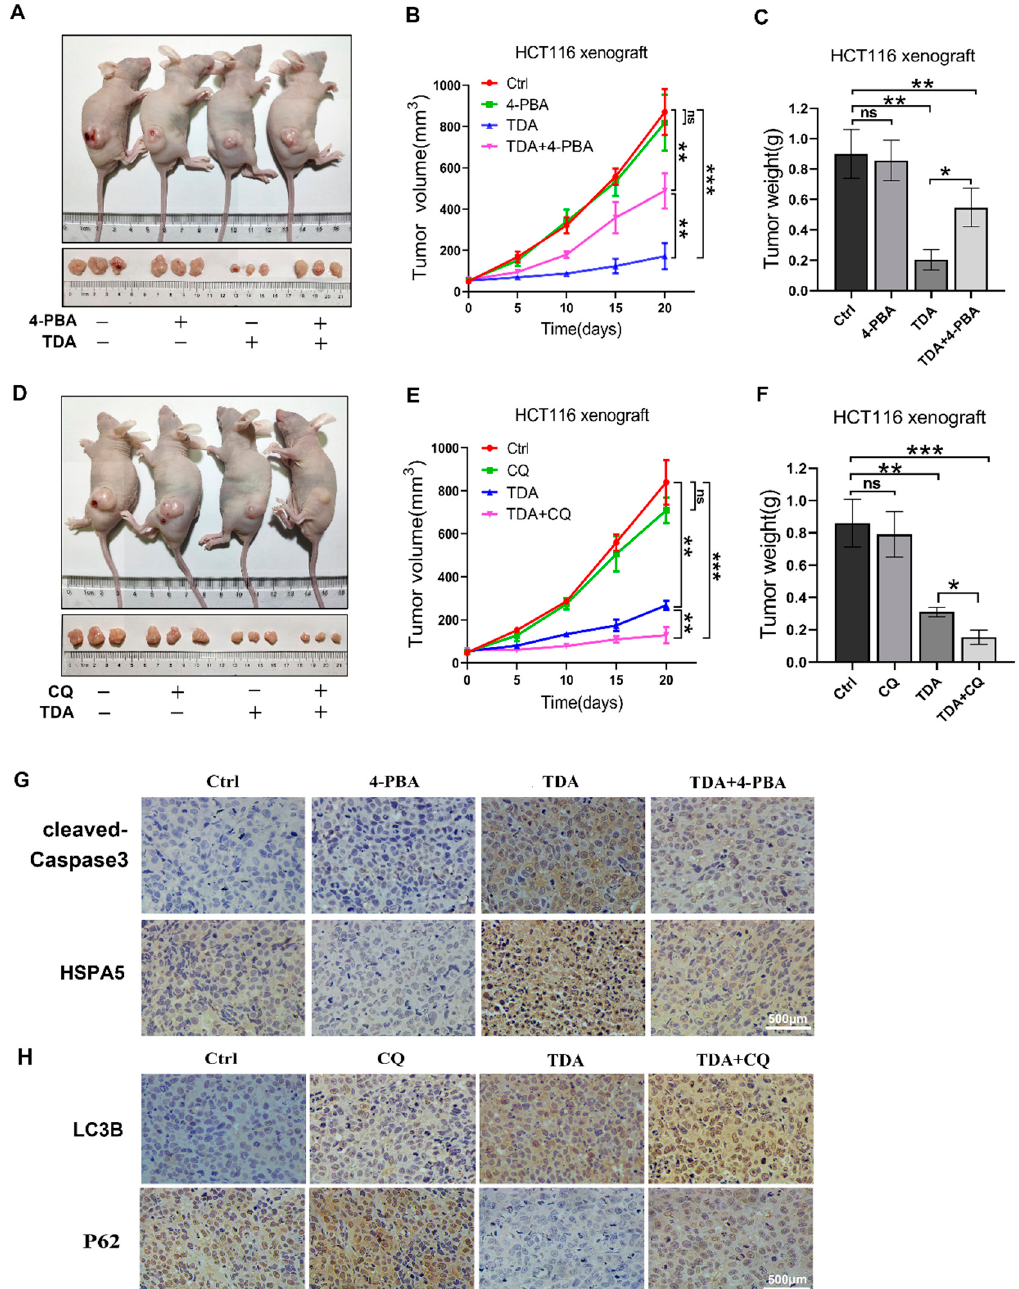
Figure 6. TDA inhibits the tumor growth in vivo. HCT116 cells were injected subcutaneously into 6-week-old nude mice. ( A – C ) When the tumor volumes reached 100 mm 3 , mice were treated with TDA alone or combination with 4-PBA as indicated. Images ( A ) and tumor weight ( B ) and volumes measured every 5 days ( C ) were shown. ( D – F ) When the tumor volumes reached 100 mm 3 , mice were treated with TDA alone or combination with CQ as indicated. Images ( D ) and tumor weight ( E ) and volumes measured every 5 days ( F ) were shown. ( G , H ) Immunohistochemical staining analysis was performed to detect the expression of cleaved Caspase3, HSPA5 ( G ), LC3B or P62 ( H ). Data are presented as mean ± SD. ns, no statistical significance; * p < 0.05; ** p < 0.01; *** p < 0.001.